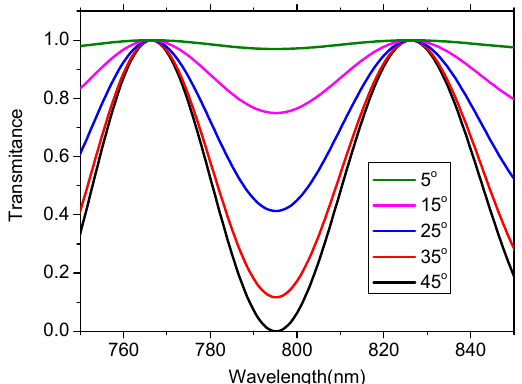
Figure 1. The transmittance spectra for different optimized WP thicknesses and rotation angle of 45 ◦ . Notice that it is a half WP for 795 nm.